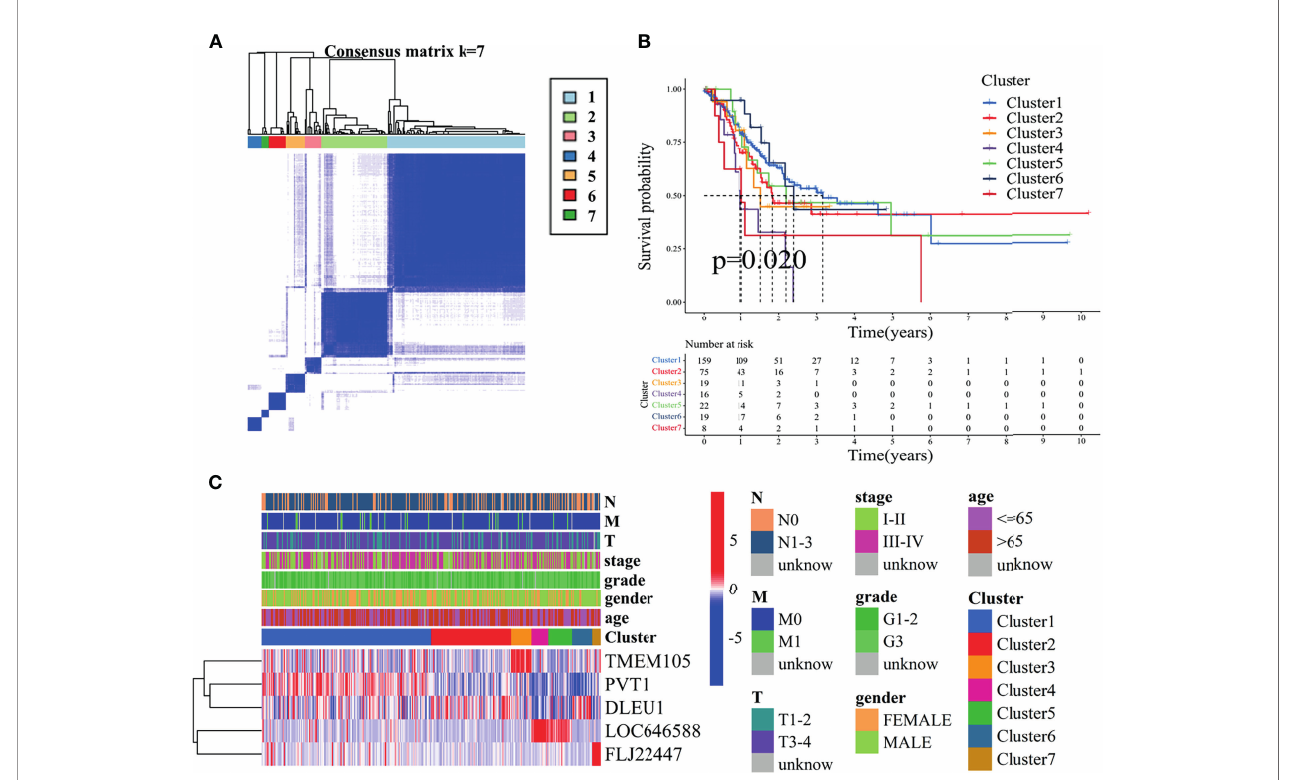
FIGURE 2 | Consensus clustering for fi ve ferroptosis-related ncRNAs in The Cancer Genome Atlas — stomach adenocarcinoma (TCGA-STAD) cohort. (A) Consensus clustering plot showing that 7 was the optical K value. The purer the color, the more appropriate the grouping and the more obvious the separation. (B) Kaplan – Meier curves for the OS of patients from TCGA-STAD cohort with the classes ( P < 0.05). They mean that, with the extension of time, the survival possibility of patients gradually decreases. (C) Heat map for ferroptosis-related ncRNAs generated by comparison of clusters and clinical characteristics. This heat map contains the expression levels of fi ve ncRNAs in seven clusters. The greater the proportion of red in a region, the higher the expression. OS, overall